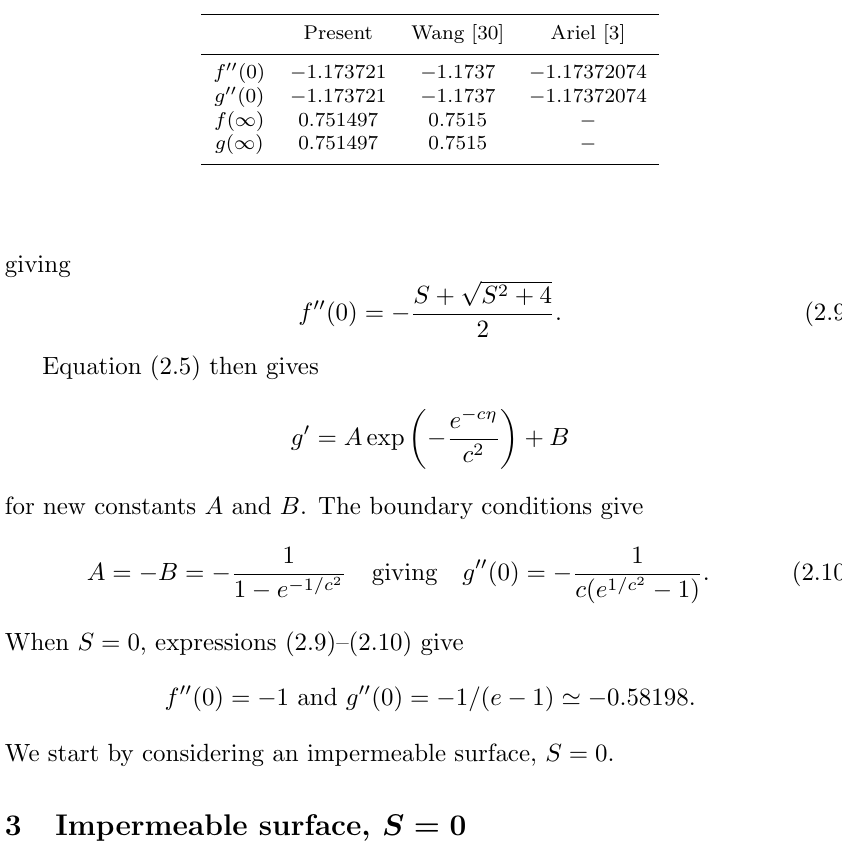
Table 1. Comparison with previous results for γ = 1 . 0 and S = 0.